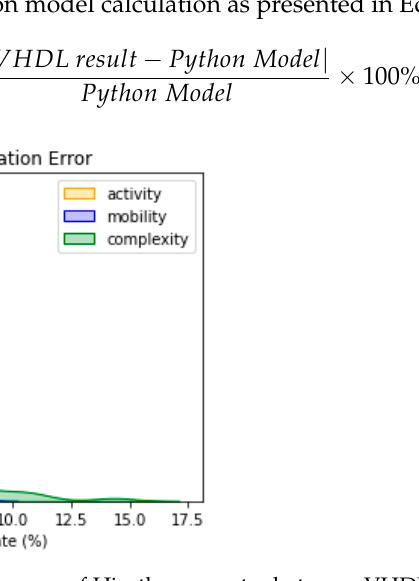
Figure 12. Distribution of calculation error of Hjorth parameter between VHDL and Python. Complexity value has the longest calculation path, resulting in a higher error calculation rate .